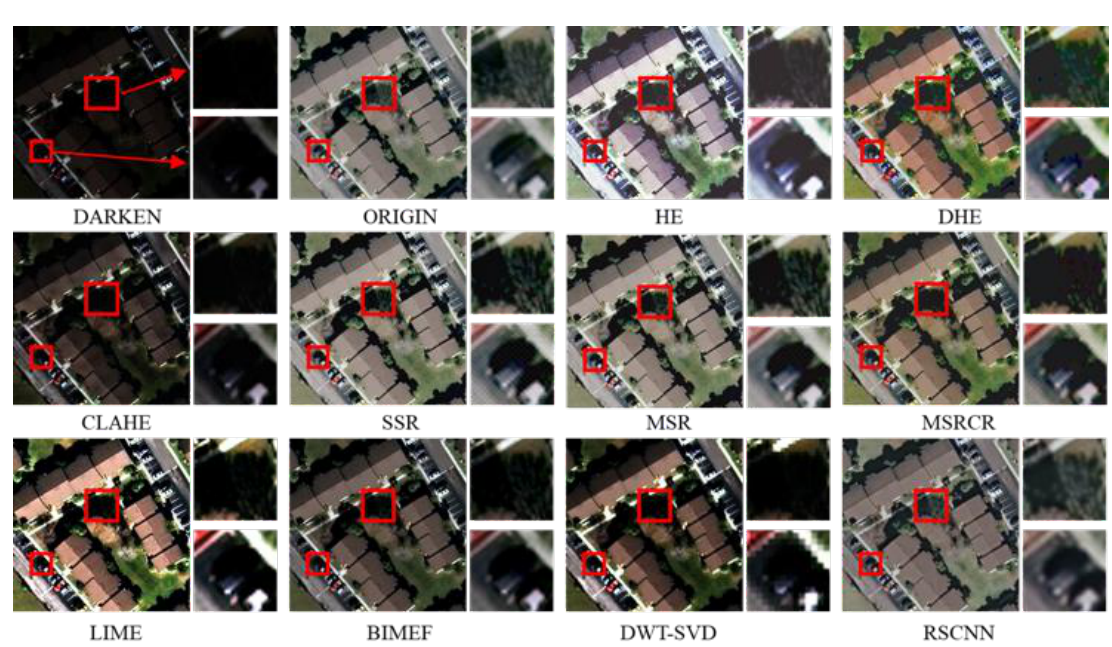
Figure 5. Results of remote-sensing image enhancement with different methods, including HE, DHE, CLAHE, SSR, MSR, MSRCR, LIME, BIMEF, DWT-SVD, and RSCNN.